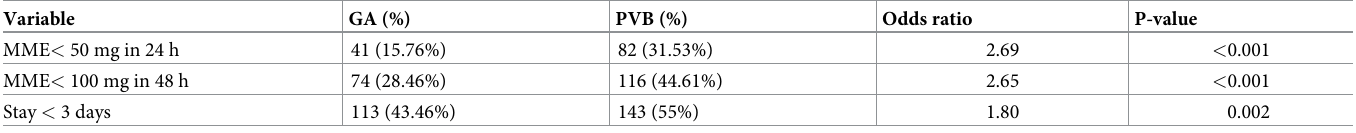
Table 5. Impact of PVB on opioid consumption and length of